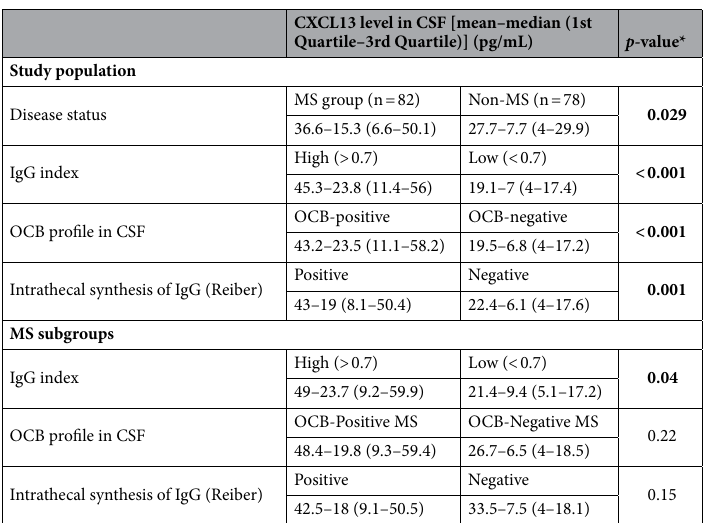
Figure 6. ROC curve for the κFLC IF performance to discriminate multiple sclerosis (MS) from non-MS patients. ROC receiver operating characteristic, FLC IF free light chain intrathecal fraction.